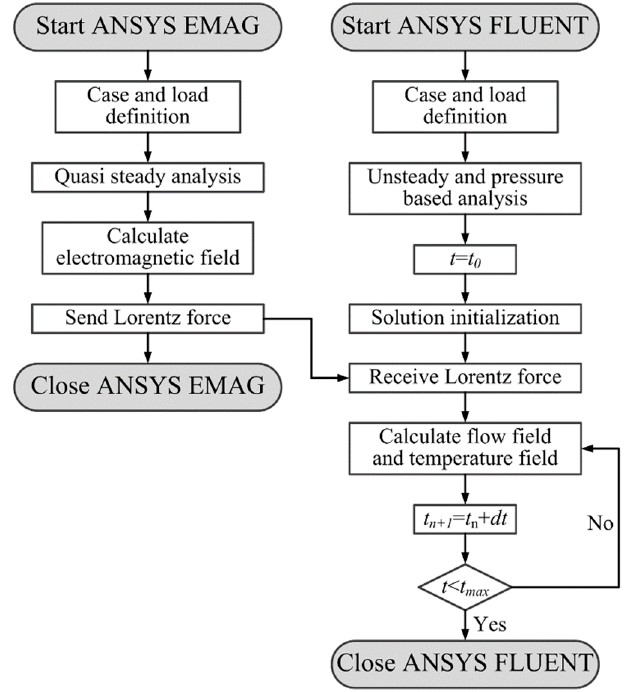
Figure 2. The flowchart of the 3D mathematical model for predicting the multi-physical phenomena in continuous casting mold with M-EMS. Table 1. The chemical compositions of 20CrMnTi steel.